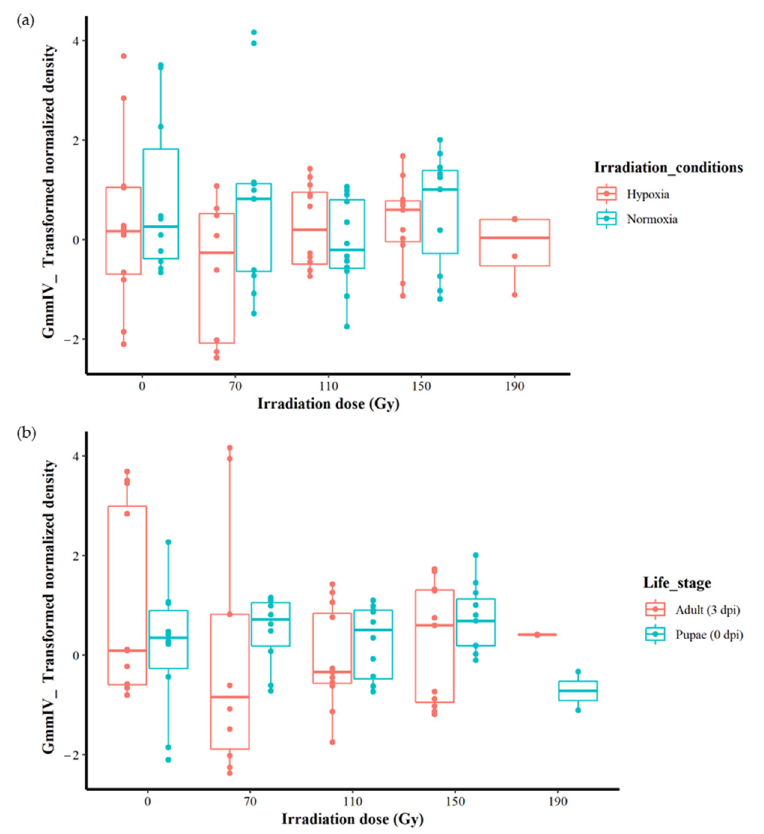
Figure 2 . Effect of irradiation conditions and host life stage on the GmmIV densities after exposure to different irradiation doses in G. morsitans morsitans . ( a ) Effect of irradiation conditions regardless host life stage. ( b ) Effect of host life stage regardless irradiation conditions.